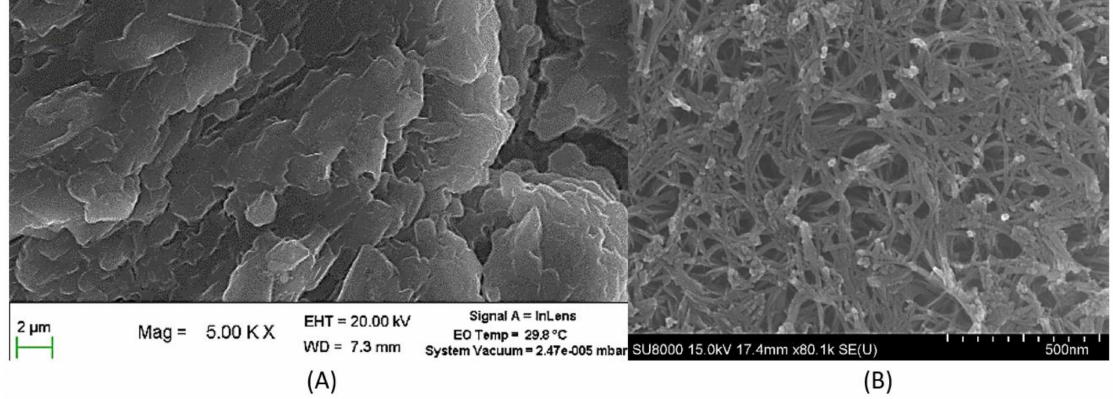
Figure 3. SEM image of pure ( A ) rGO and ( B )